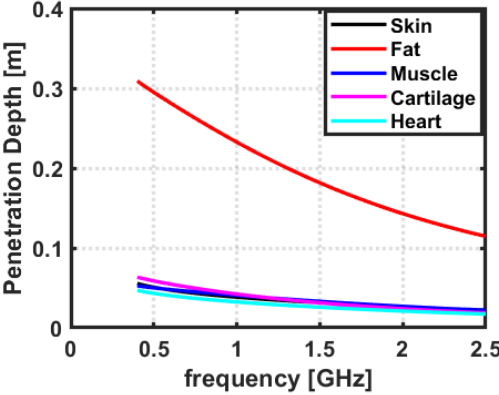
Figure 8. The penetration depth of considered tissues as a function of frequency. The values are taken from Gabriel et al. [36].